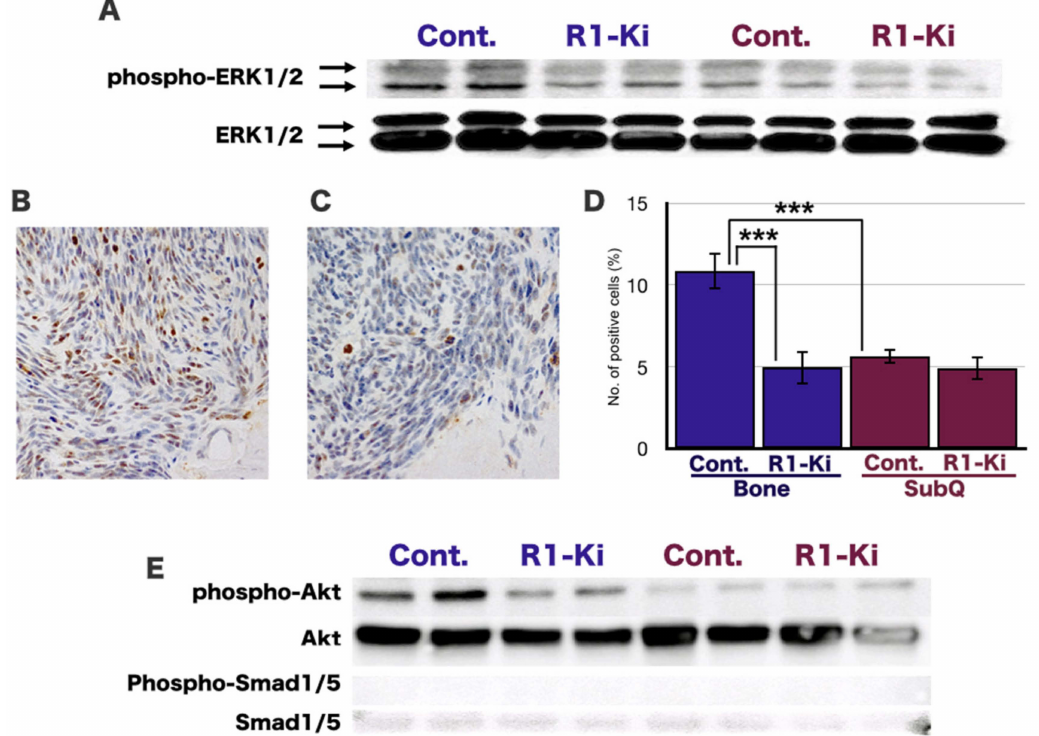
Figure 6. The involvement of ERK1 / 2 and AKT, and BMP signaling, in the bone and subQ micro-Es. A : Western blot analysis: The expression of p-ERK1 / 2 was relatively strong in the bone micro-E and weak in the subQ micro-E. The expression of ERK1 / 2 was similar in the bone and subQ micro-Es regardless of treatment ( A ). ( B , C ) IHC study of p-ERK1 / 2 staining in the bone micro-E: A large number of p-ERK1 / 2 positive cells can be seen in the control group ( B ) and fewer positive cells in the R1-Ki treatment group ( C ). Magnification: 400 × . ( D ) Quantitative analysis of p-ERK1 / 2 positive cells: R1-Ki treatment significantly reduced the number of positive cells in the bone micro-E but not in the subQ micro-E. ( E ) Expression of phosphorylated AKT and AKT: Strong expression of phosphorylated AKT was observed of the control group and weaker expression of the R1-Ki treatment group in the bone micro-E. Weak expression of p-AKT was observed in both the control and R1-Ki treated groups in the subQ micro-E. The expression of AKT was similar in the bone and subQ micro-Es regardless of treatment. ( E ) Expression of SMAD1 / 5: The expression of SMAD1 / 5 was only slightly detected, and the expression of p-SMAD1 / 5 was not detected in either the bone or subQ micro-E regardless of treatment. ***: p <